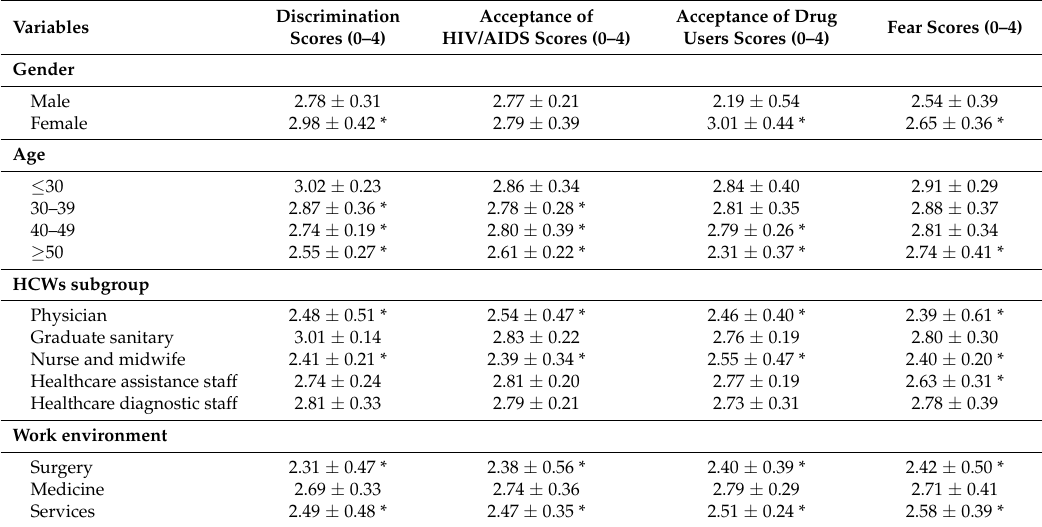
Table 2. Scores obtained from HCWs.